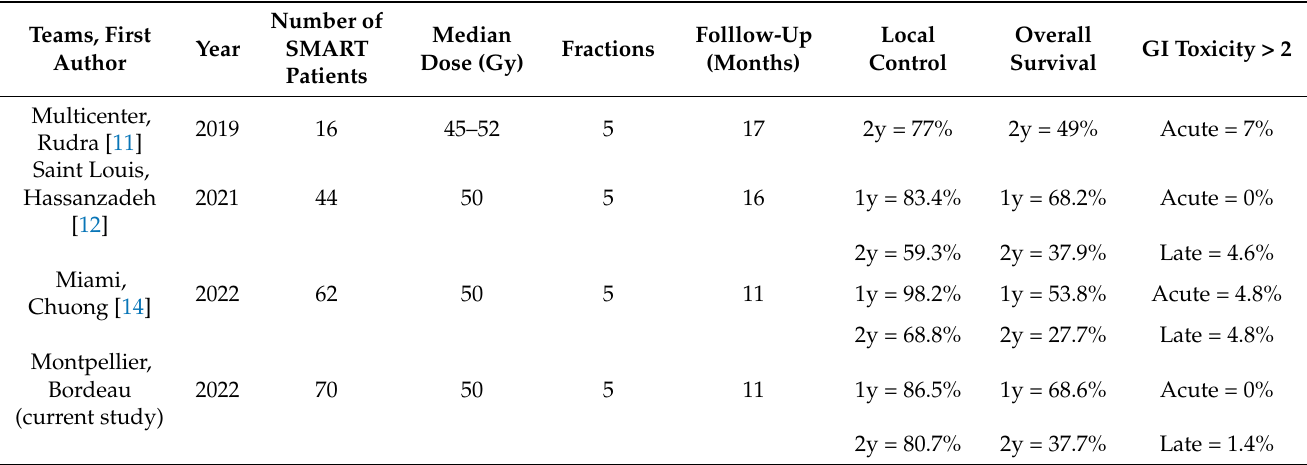
Table 5. Main published SMART studies for pancreatic tumors. (Local control and overall